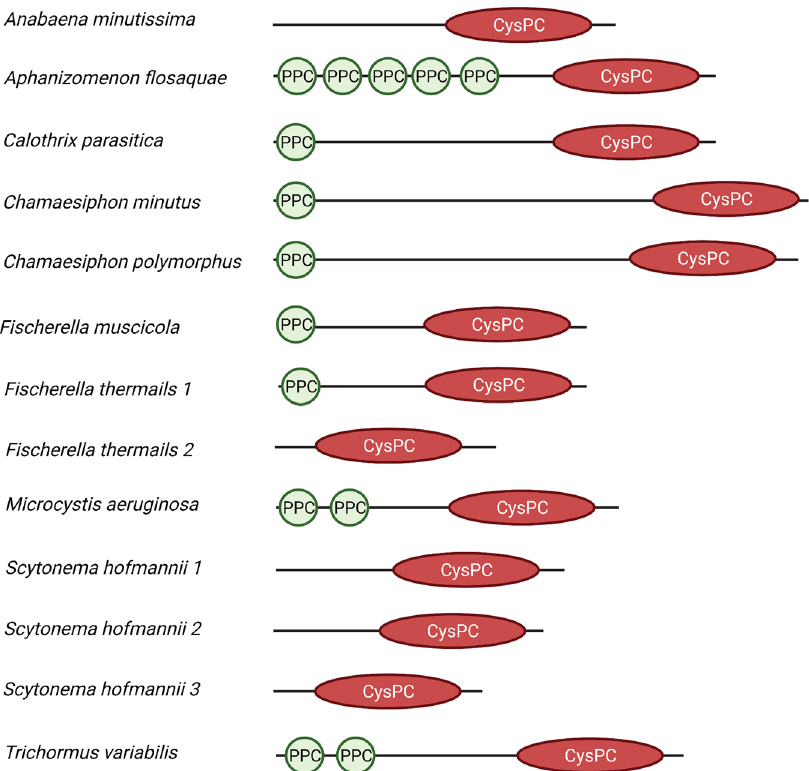
Figure 2. Domain structure of the identified cyanobacterial calpains. All calpains contain CysPc conserved domain (red ellipse) with a catalytic triad C, H, N typical for calpains. Some calpains possess the second conserved domain, PPC (green circle), which can be present in several